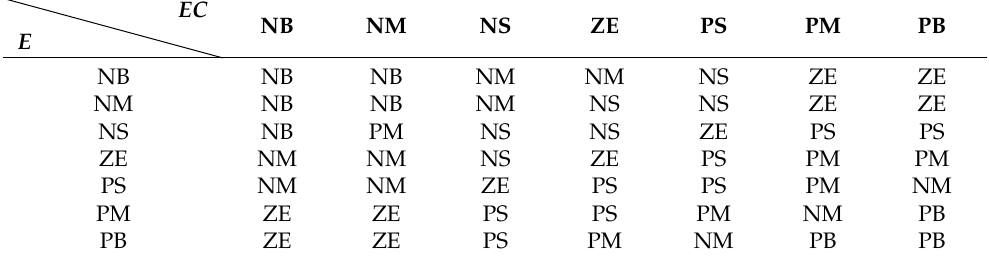
Table 2. ∆ K I Fuzzy rules